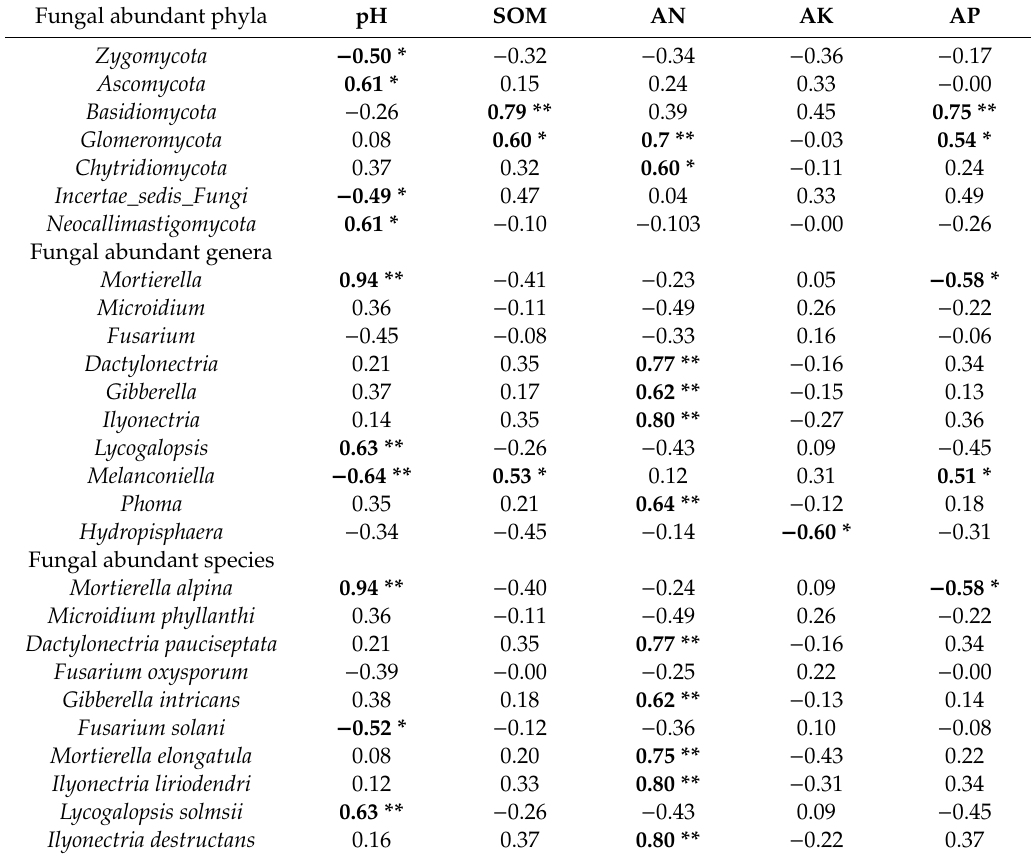
Table 3. Pearson’s correlation between soil properties and abundant taxa of fungi (phyla, genera, and species) in control and di ff erent age monoculture tea